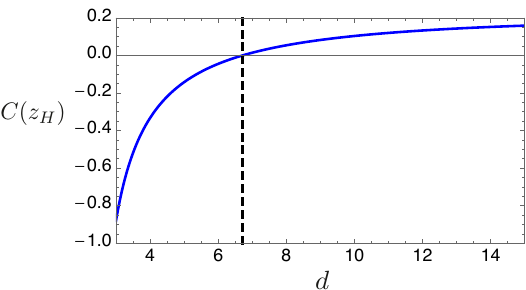
Figure 6. The dimensionless coe(cid:14)cient C ( z H ) from eq. (2.23) for AdS-SCH, versus dimension d . At d = 3, C ( z H ) (cid:25) (cid:0) 0 : 88, and C ( z H ) then increases monotonically with d , reaching zero at d crit (cid:25) 6 : 7, indicated by the dashed black vertical